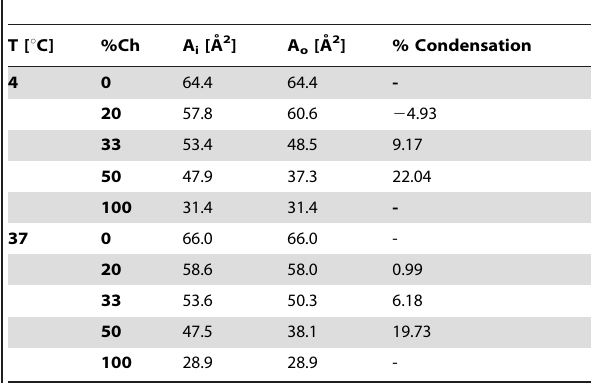
Table 1. Average molecular area vs. composition and percent condensation values for a monolayer measured at a surface pressure of 3 mN/m for 25 u